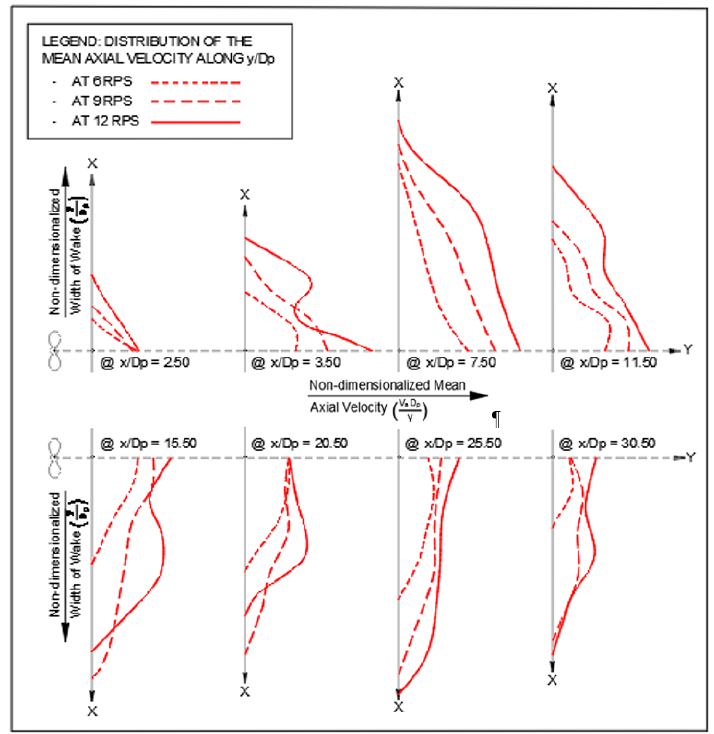
Figure 5. The approximate patterns of the distribution of the non-dimensionalized mean axial velocities (cid:4672) (cid:2906) (cid:3159) (cid:2888) (cid:3148) V a D P ν (cid:4673) along y/D p with the change of ‘n’.